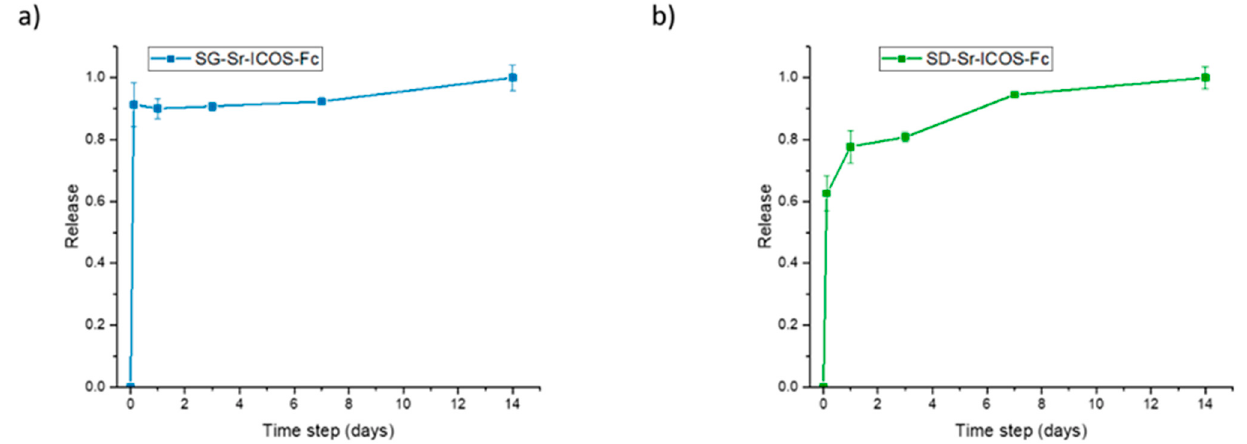
Figure 8. Strontium release profiles of SG-Sr-ICOS-Fc ( a ) and SD-Sr-ICOS-Fc ( b ).